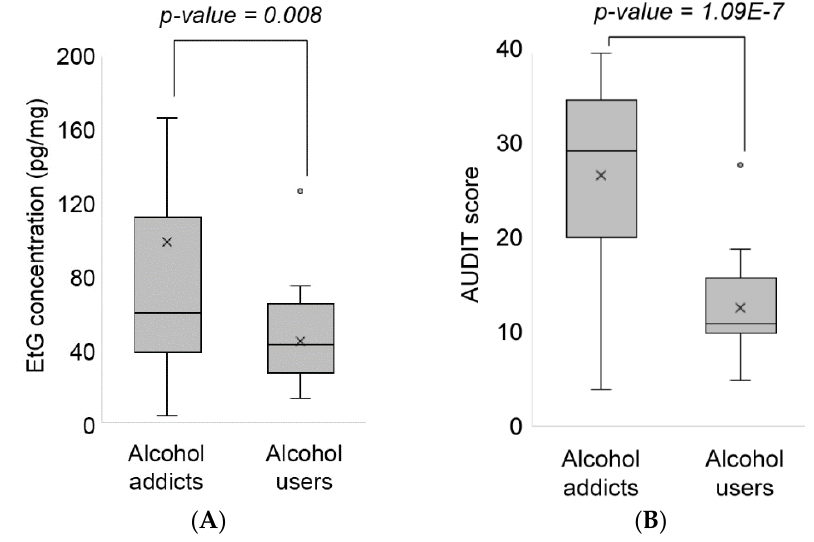
Figure 4. Distribution of the hair EtG concentrations ( A ) and the AUDIT scores ( B ) in alcohol addicts ( n = 44) and average alcohol users ( n = 19).